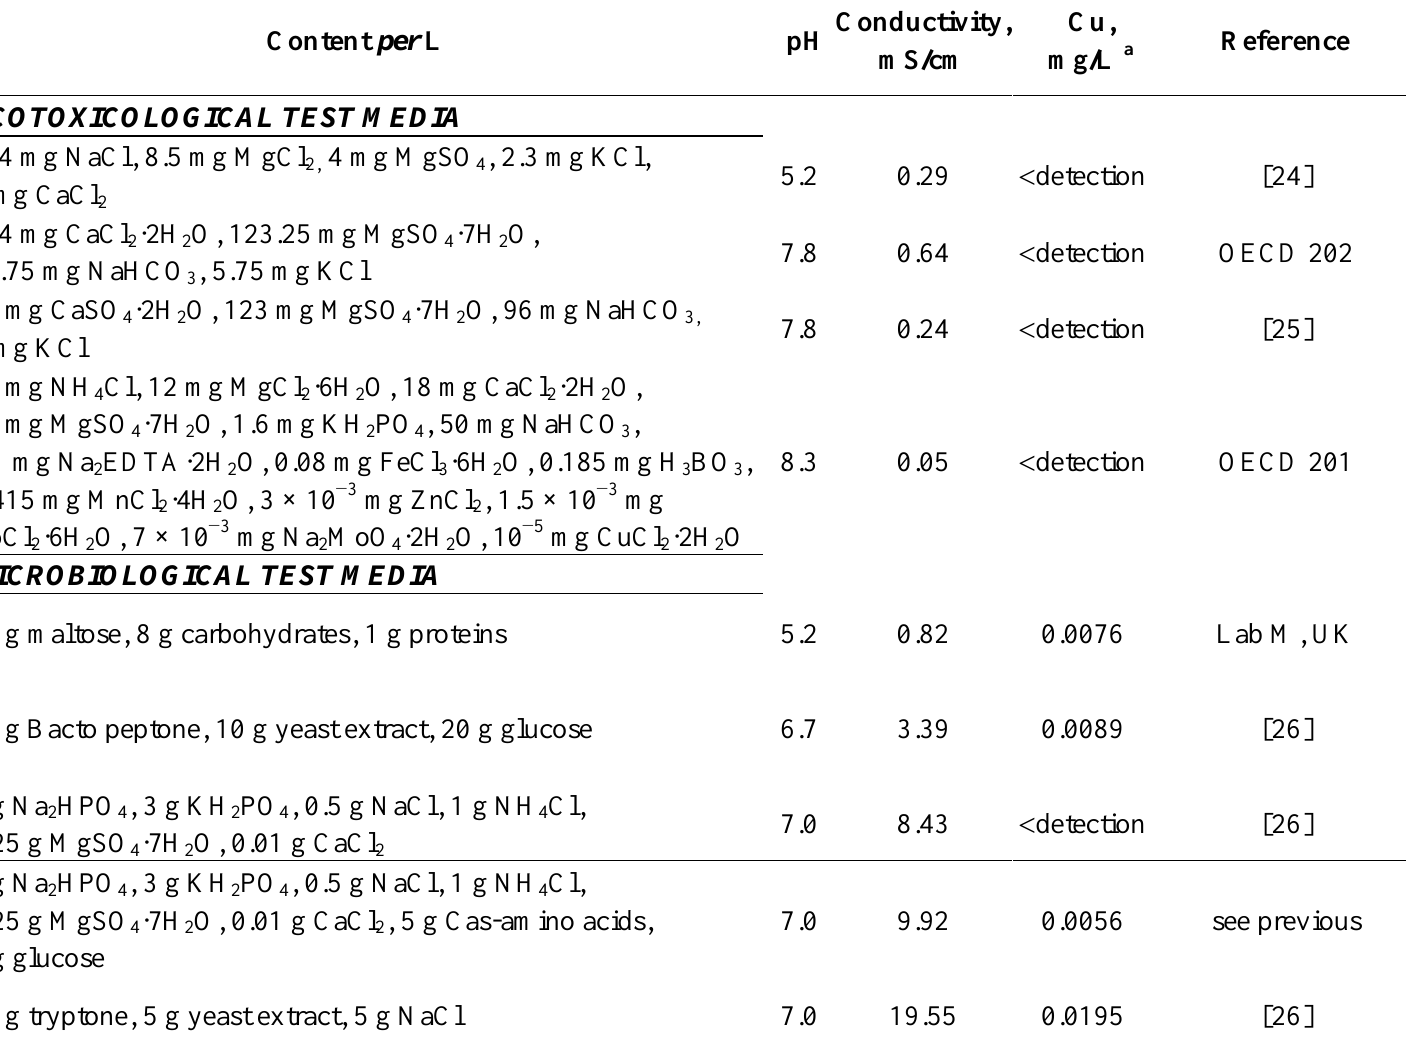
Table 1. Toxicological and microbiological test media used in this